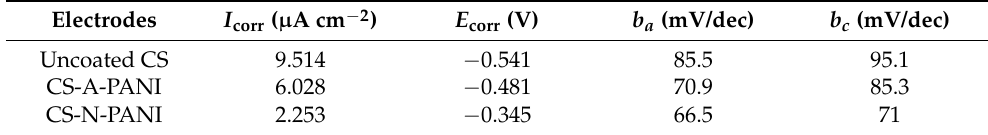
Figure 5. Tafel curves for uncoated CS (a), CS − A − PANI (b), and CS − N − PANI (c) in 3.5 wt% NaCl aqueous solution. Table 1. Tafel curves parameters for uncoated CS, CS-A-PANI, and CS-N-PANI in 3.5 wt% NaCl